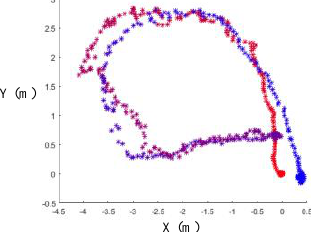
Figure 7. Sensor’s location during scanning time.